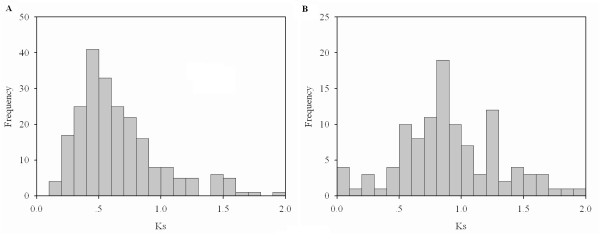
Distribution of synonymous substitution rate (Ks) for CNMS gene sets. (A) Distribution of Ks values for Arabidopsis-Brassica orthologous CNMS gene set. A clear peak for Ks values of 0.4 to 0.5. (B) Distribution of Ks values for paralogous CNMS gene set in Arabidopsis. Two clear peak for the Ks values of 0.8 to 0.9 and 1.2 to 1.3.